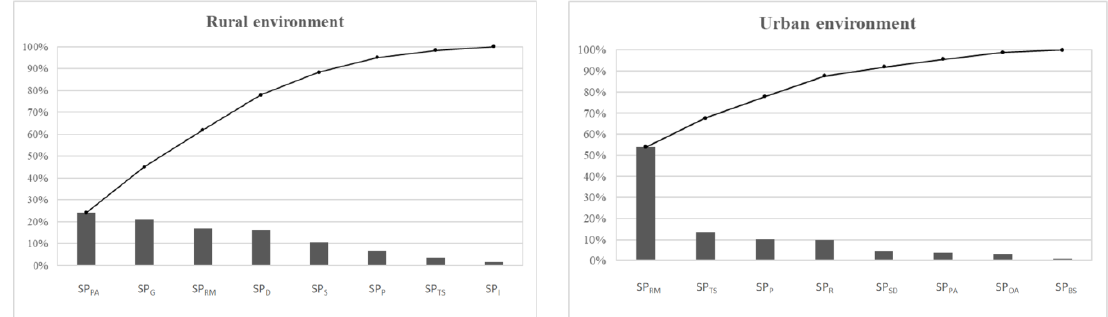
Figure 6. Pareto charts of safety performance indicator (SP k ) values for the test site, for rural and urban environments, re- spectively.